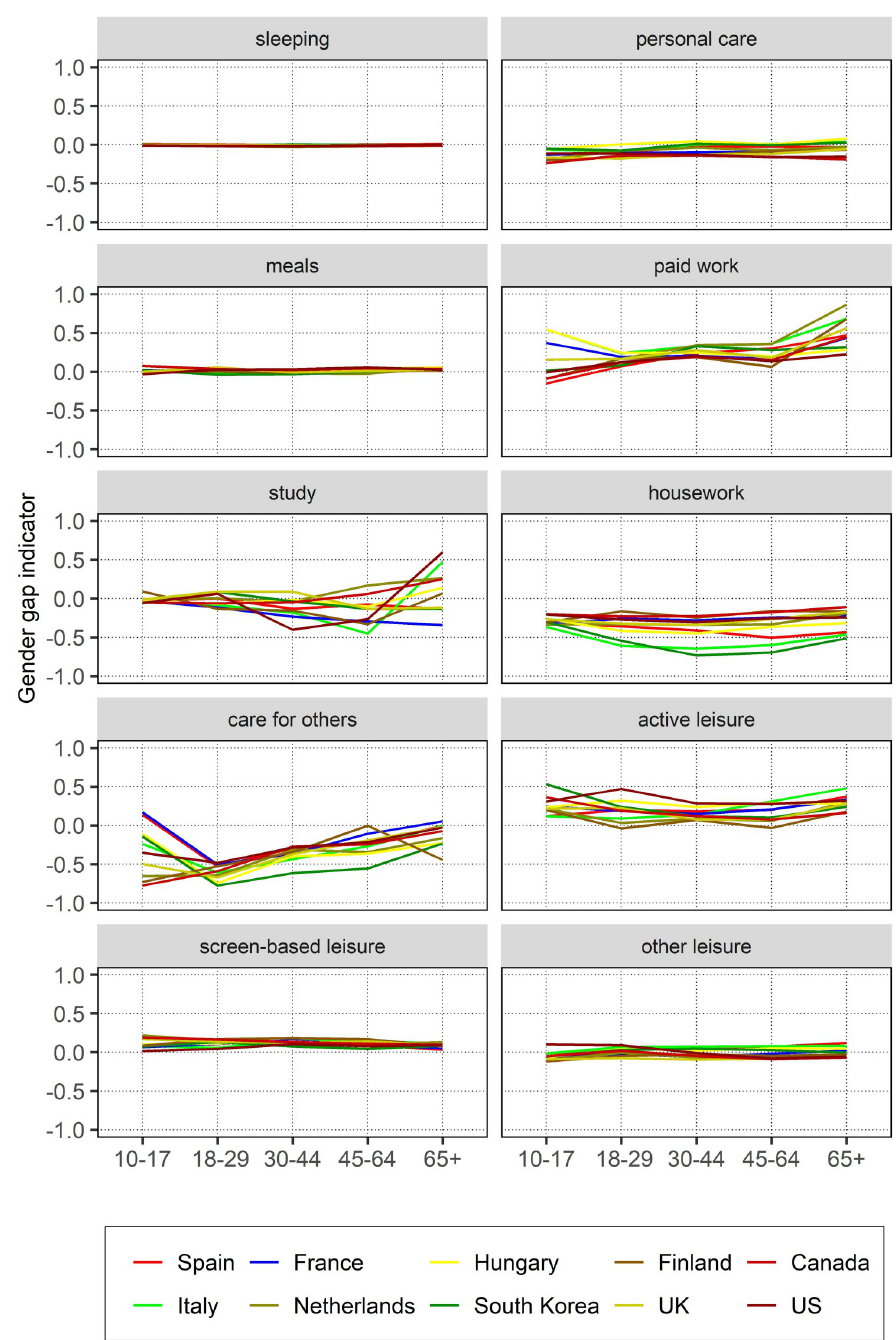
Fig 3. Gender gaps in time use (Indicator from -1 to 1). Differences in activities by age. Source: Own calculations from the Multinational Time Use Study [32]. � Estimates of the figure available in Table 4. and with separated models for each group age and country, without adding demographic and socioeconomic controls, and only controlling for day of the week. In Panel B, we present the same analyses, adding also a control of day of the week, but in this case we control for multiple